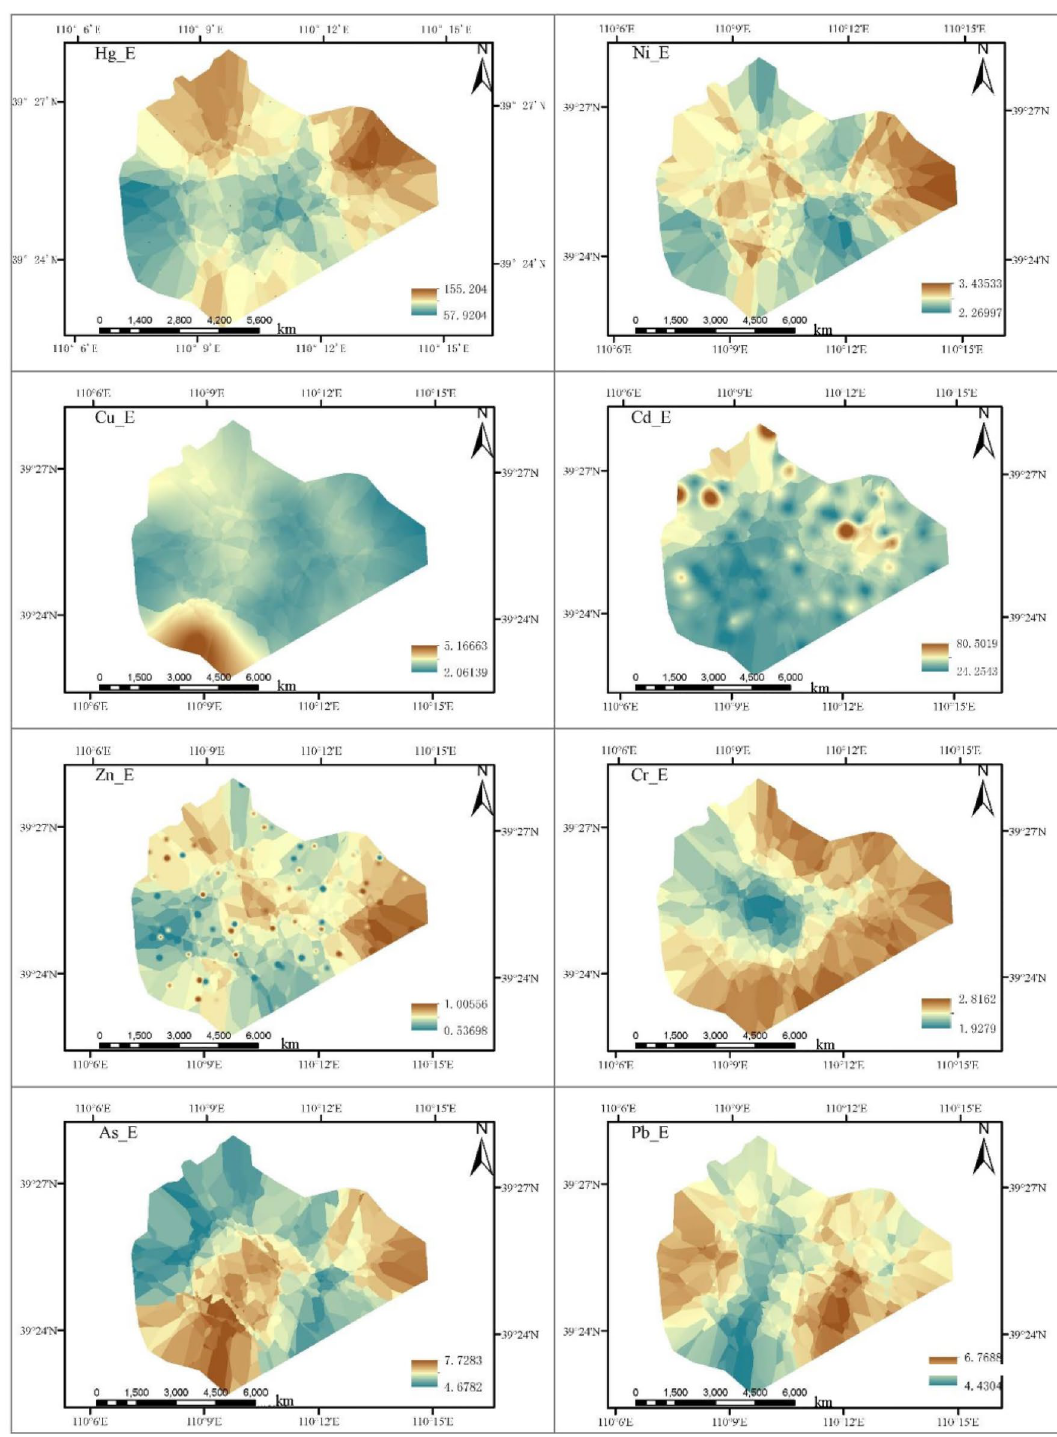
Figure 3. Spatial distribution of single ecological risk index (E) of heavy metals (created by Arcgis 10.8, http:// deskt op. arcgis. com/